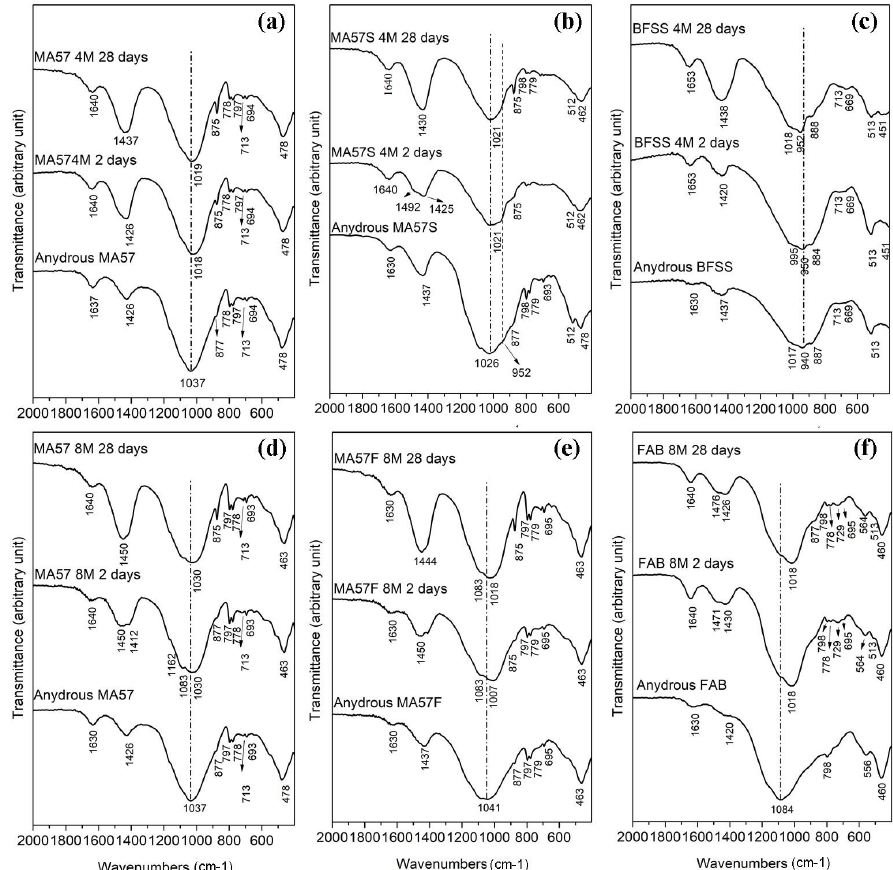
Figure 5. FTIR spectra of precursors (in the bottom part of each panel) and alkali activated pastes detected at two and 28 days of curing: ( a ) MA57_4M, ( b ) MA57S_4M, ( c ) BFSS_4M, ( d ) MA57_8M, ( e ) MA57F_8M and ( f ) FAB_8M.